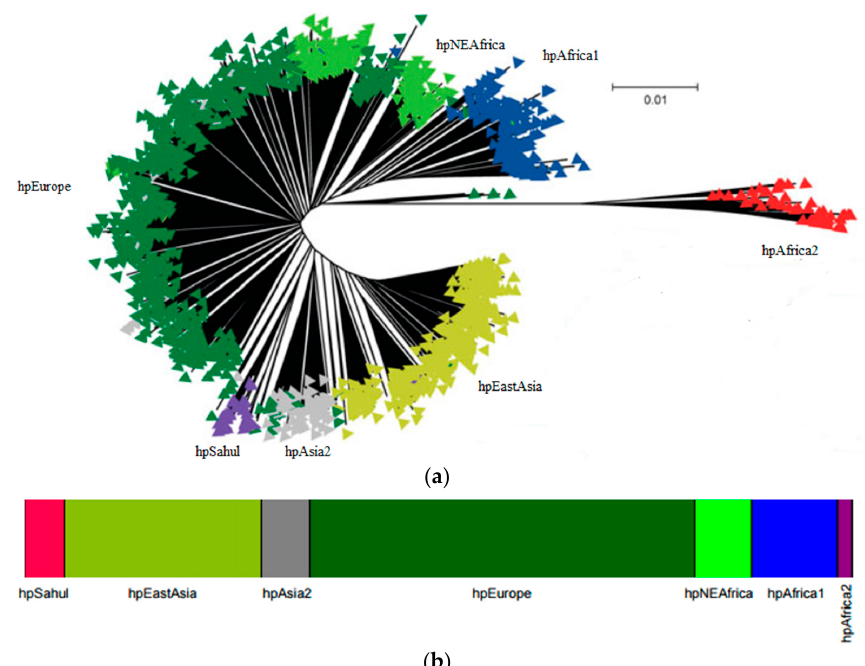
Figure 1. Worldwide population structure of H. pylori : ( a ) Neighbor-joining tree using Kimura two-parameter model of the concatenated H. pylori housekeeping genes (adapted with permission from [22]); ( b ) DISTRUCT plot of the Bayesian assignment of H. pylori to populations using STRUCTURE V2.0 with no admixture model, where each isolate is represented by a thin line that is color coded according to the population assignment (adapted with permission from [3]).